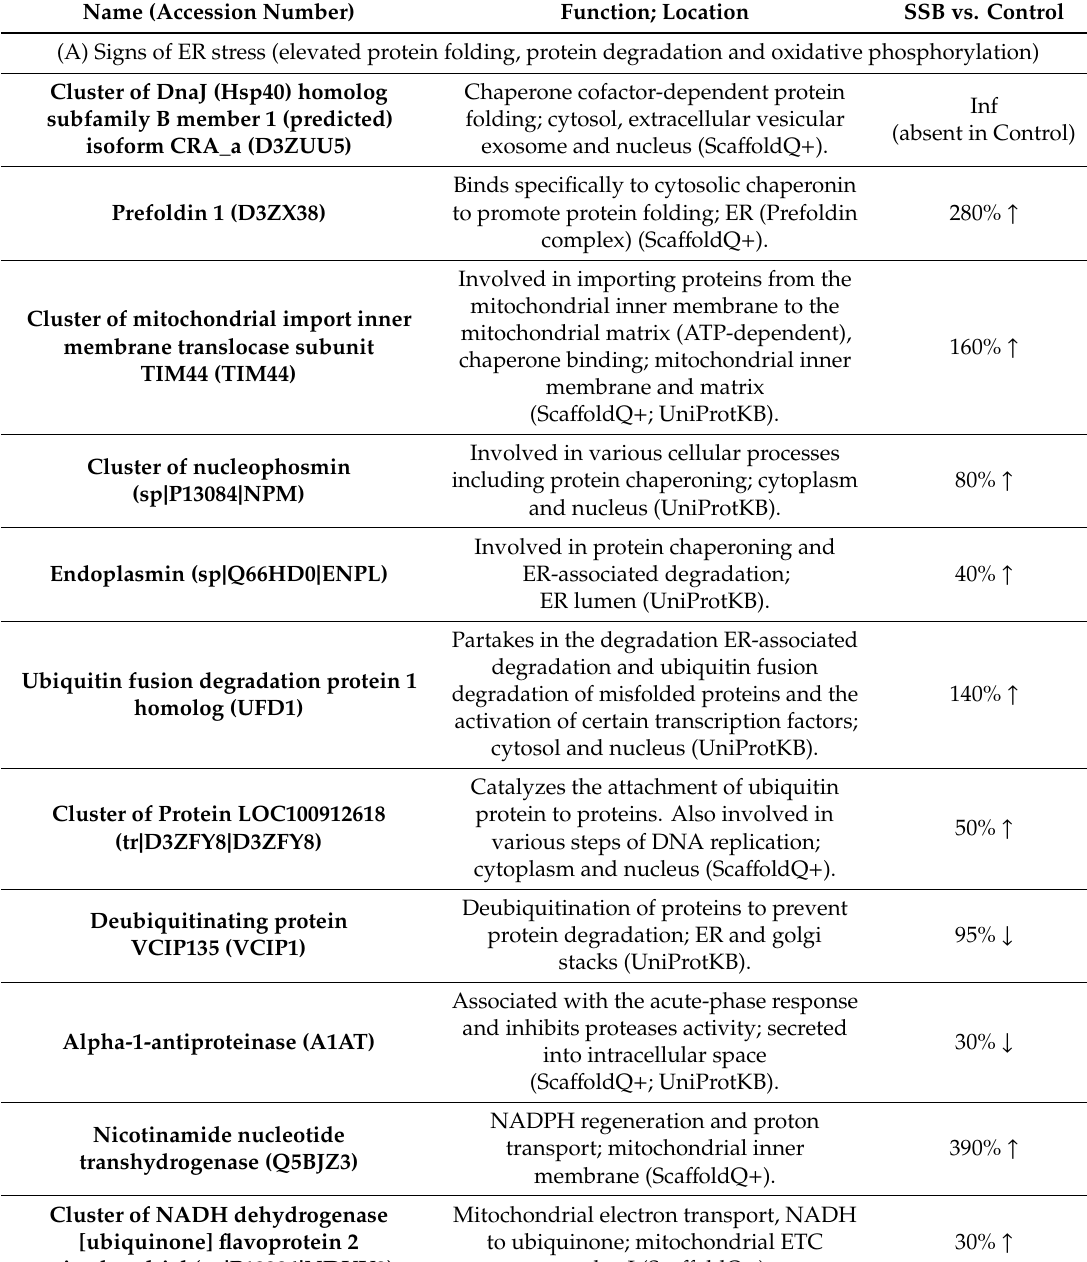
Table 1. SSB-induced changes in protein expression (listed according to